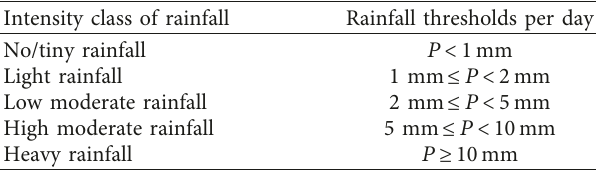
Table 3: Rainfall intensities and thresholds.